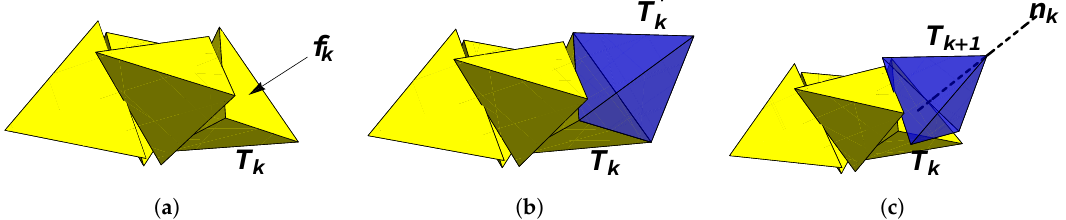
Figure 4. Assembly of a modified BC helix. ( a ) A segment of a modified BC helix with face f k identified on tetrahedron T k . ( b ) An intermediate tetrahedron, T (cid:48) on T k . ( c ) Finally, T k + 1 is obtained by rotating T (cid:48)